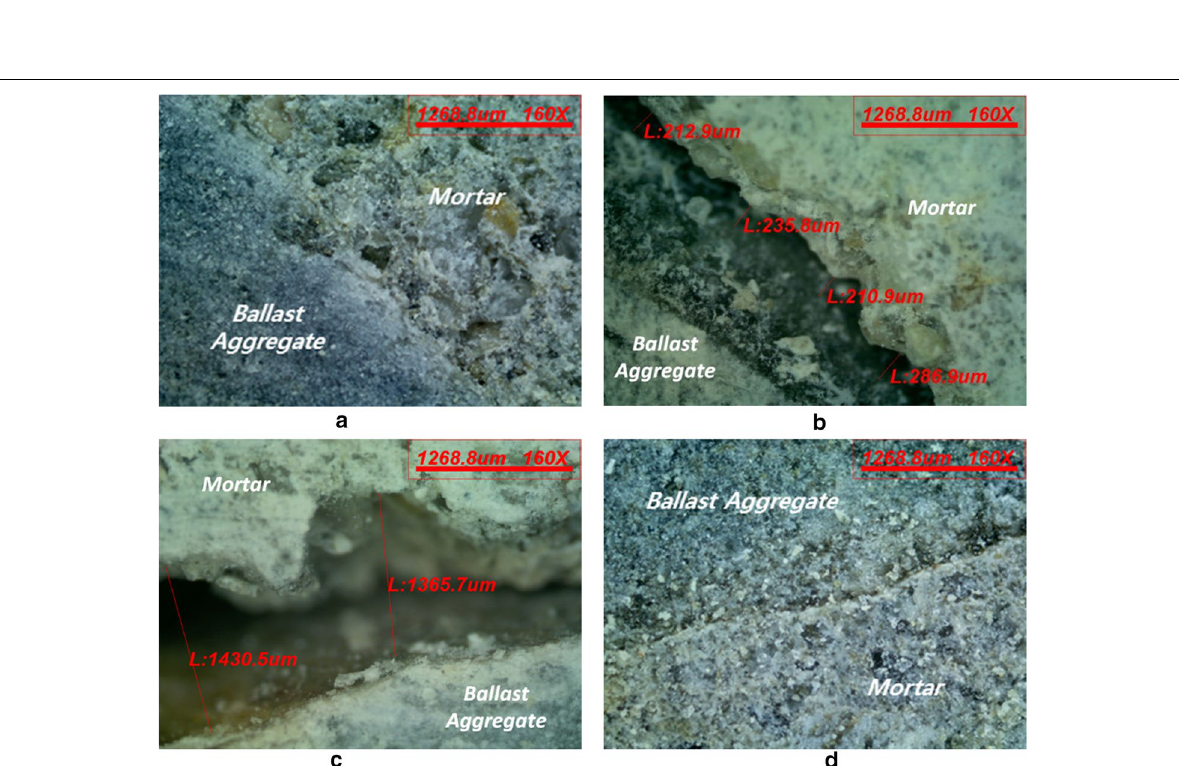
Fig. 24 Damaged ITZs with L-level aggregates after freeze–thaw testing: a C-L-0, b C-L-2, c C-L-6, and d C-L-10 [magnification factor: